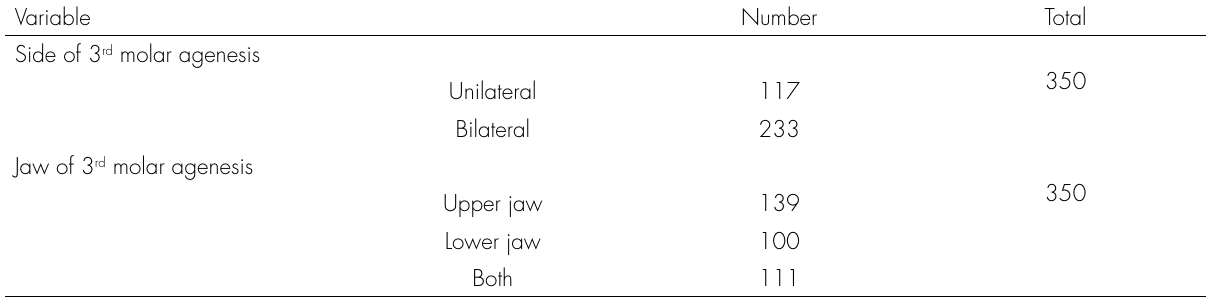
Table I. Distribution of subjects according to the side and jaw of missing third